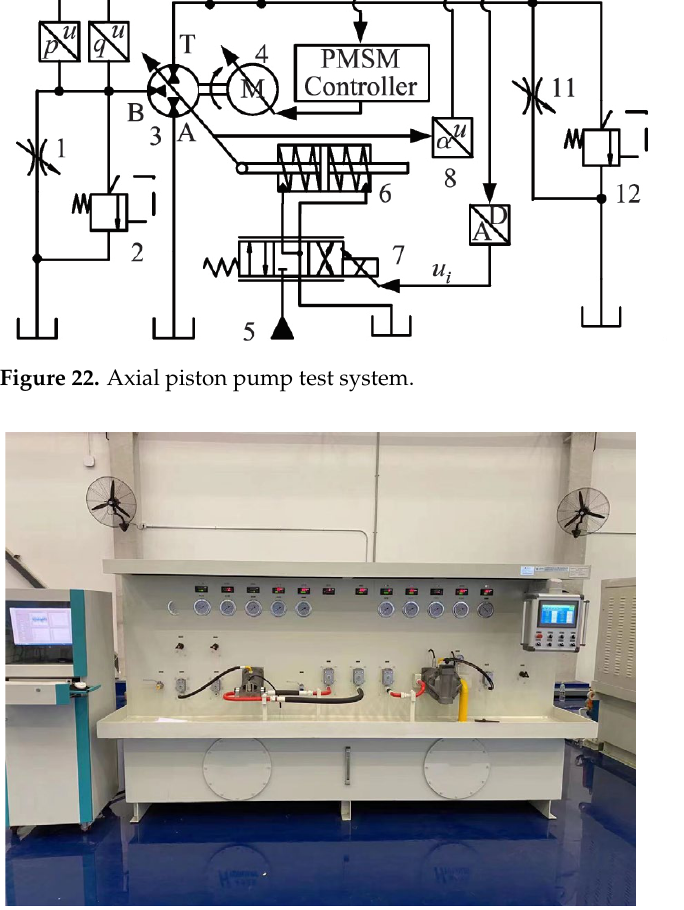
Figure 23. The experimental station.